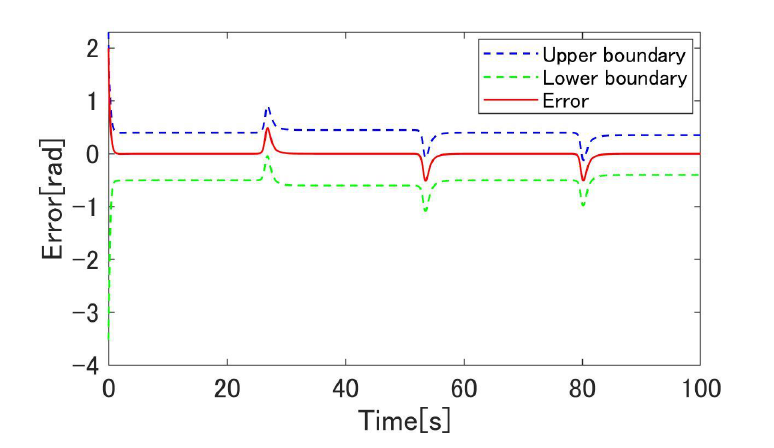
Figure 12. The error e and boundary functions F and F of the proposed